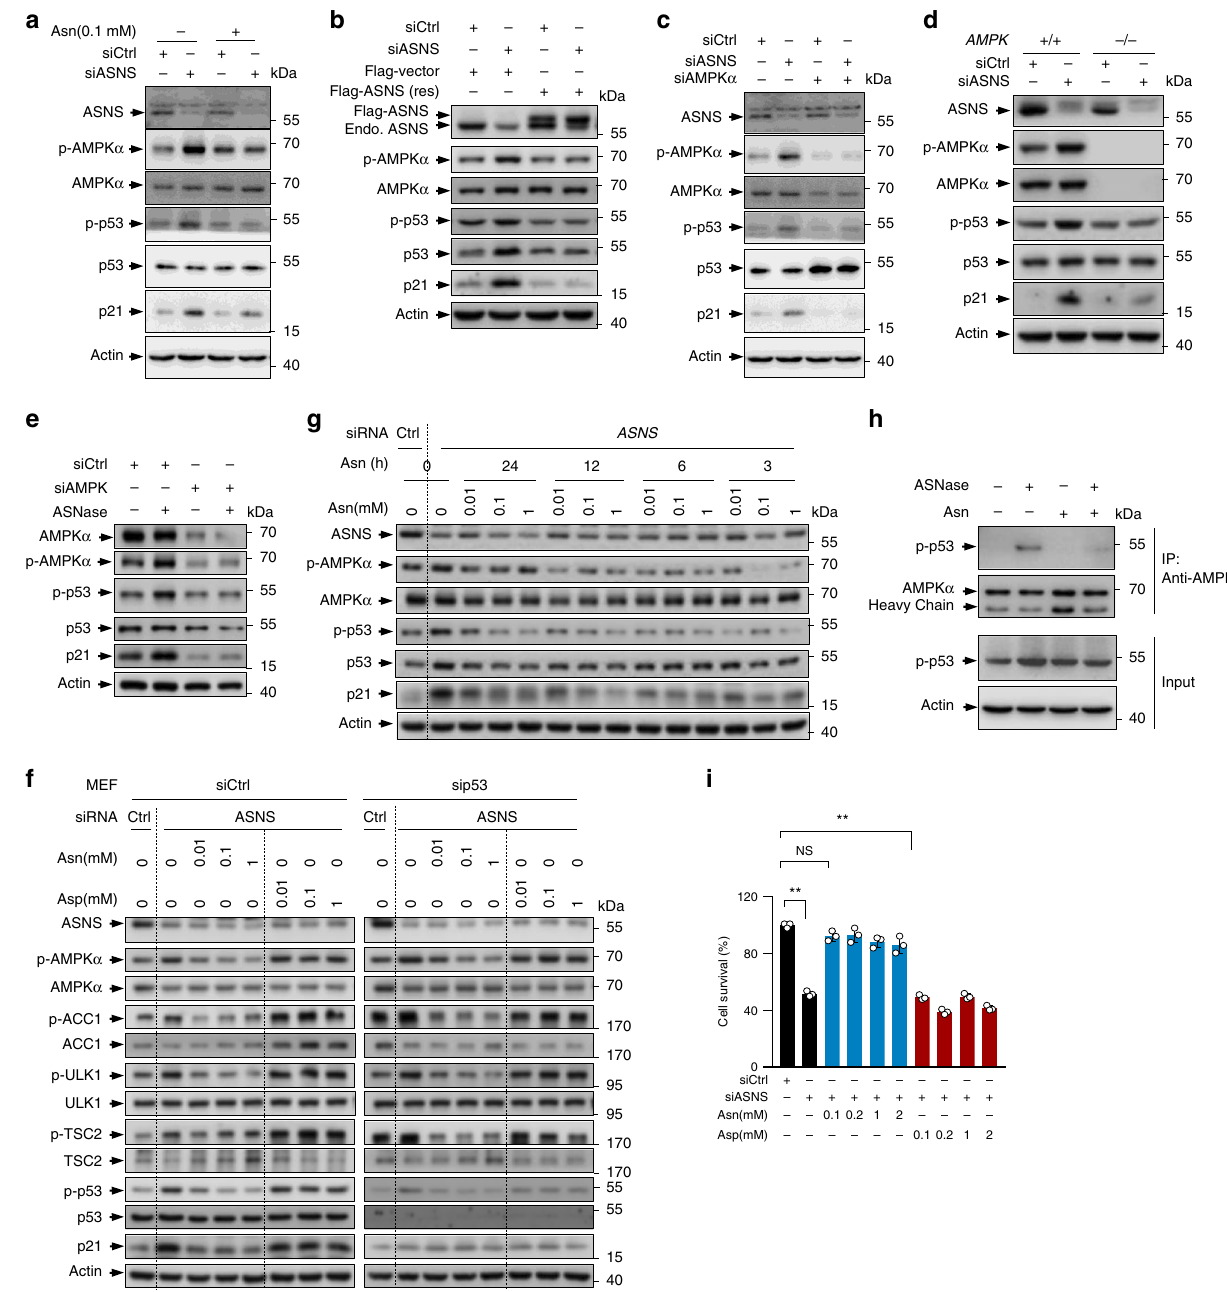
Fig. 5 ASNS and asparagine regulate p53 through AMPK. a HCT116 cells transfected with control or ASNS siRNA were cultured in medium containing 0 or 0.1 mM Asn for 3 days. Protein expression was analysed by western blotting. b U2OS cells stably expressing Flag-tagged RNAi-resistant (res) ASNS or Flag vector control were transfected with control or ASNS siRNA for 72 days. Protein expression was analysed. c Expression of the indicated proteins in HCT116 cells transfected with control, ASNS siRNA and/or AMPK α siRNA as indicated for 3 days. d Western blot analysis of lysates from AMPK + / + and AMPK − / − MEFs transfected with control or ASNS siRNA as indicated for 3 days. e HCT116 cells transfected with control or AMPK siRNA were cultured in medium containing 0 or 2 U per ml ASNase for 48 h. Protein expression was analysed. f MEFs transfected with control, p53 siRNA or ASNS siRNA were treated with or without increasing amounts of Asn or aspartate Asp as indicated. Protein expression is shown. g MEFs transfected with control or ASNS siRNA were treated with or without increasing amounts of Asn for the indicated time points. The expression of the indicated proteins was analysed by western blotting. h HCT116 cells cultured in control medium or medium containing ASNase and/or 0.1 mM asparagine as indicated for 48 h. Cells were harvested and subjected to immunoprecipitation using anti-AMPK antibody, and bound proteins were analysed by western blotting. i MEFs transfected with control or ASNS siRNA were treated with or without increasing amounts of Asn or Asp as indicated. Relative cell viability (%) is shown. Data are mean ± s.d., unpaired two-tailed Student ’ s t -test, * p < 0.05, ** p < 0.01, *** p < 0.001, NS not signi fi cant. Source data are provided as a Source Data fi